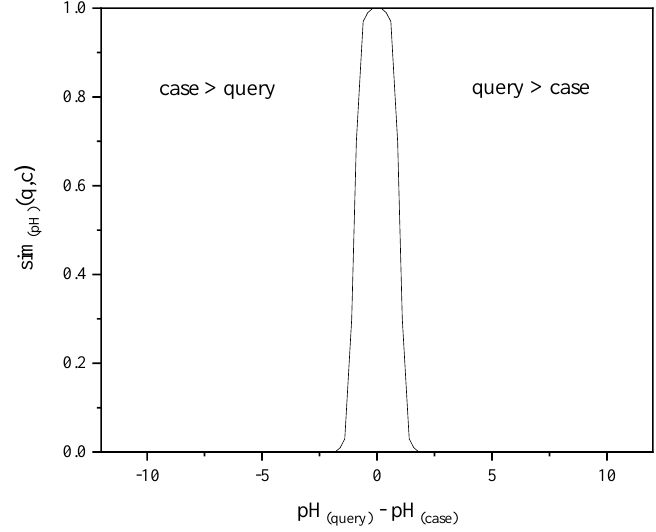
Figure 4. Illustration of the default similarity function for pH in the LeachSim model.